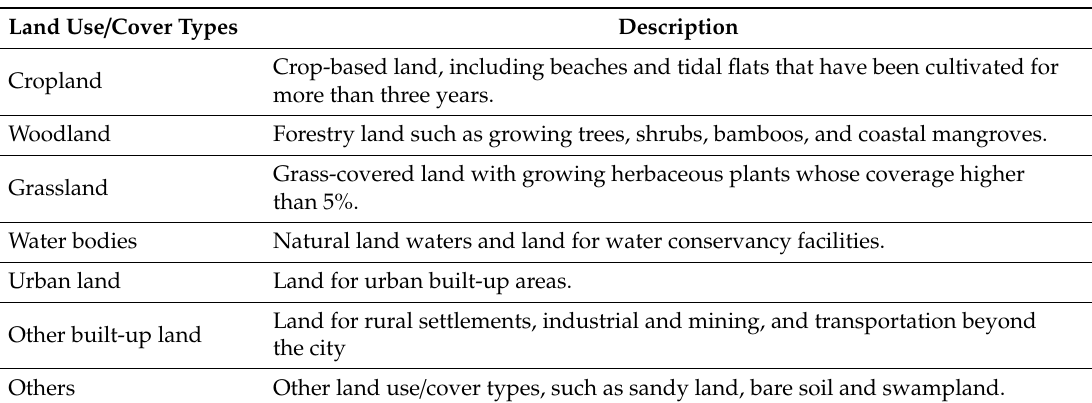
Table 2. The land use / cover classification